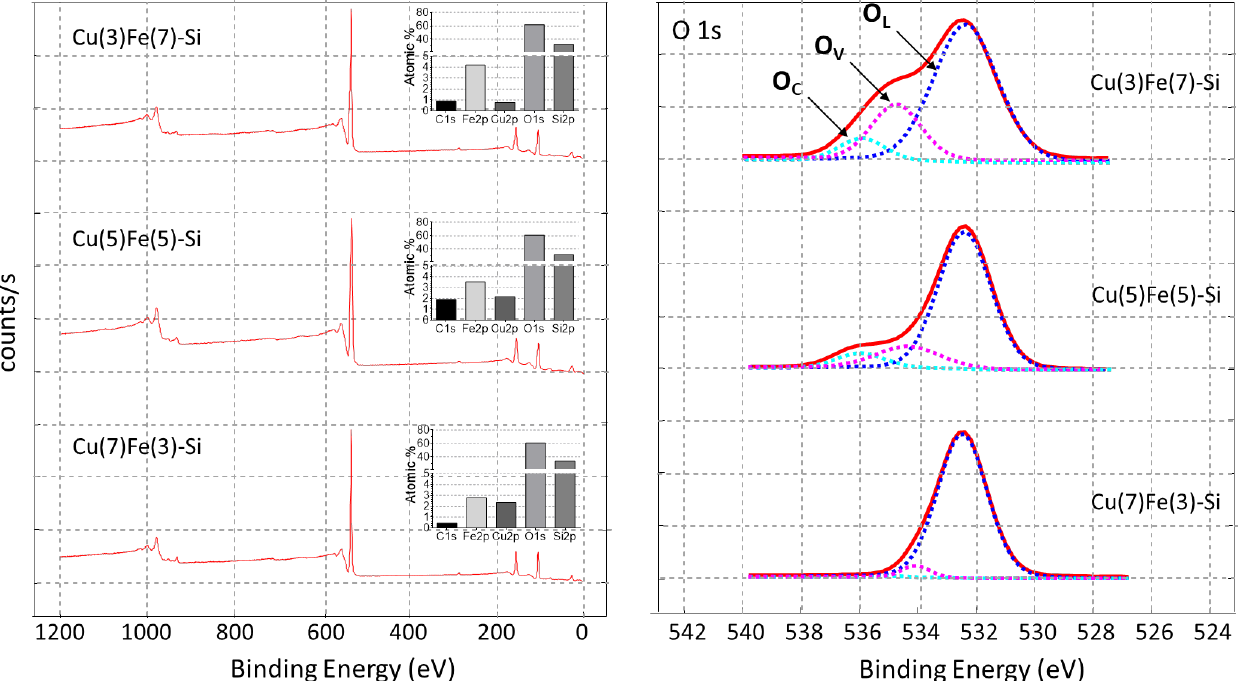
Figure 7. XPS survey scans of the reduced bimetallic samples ( left ) and deconvolution of O 1s peak ( right ).